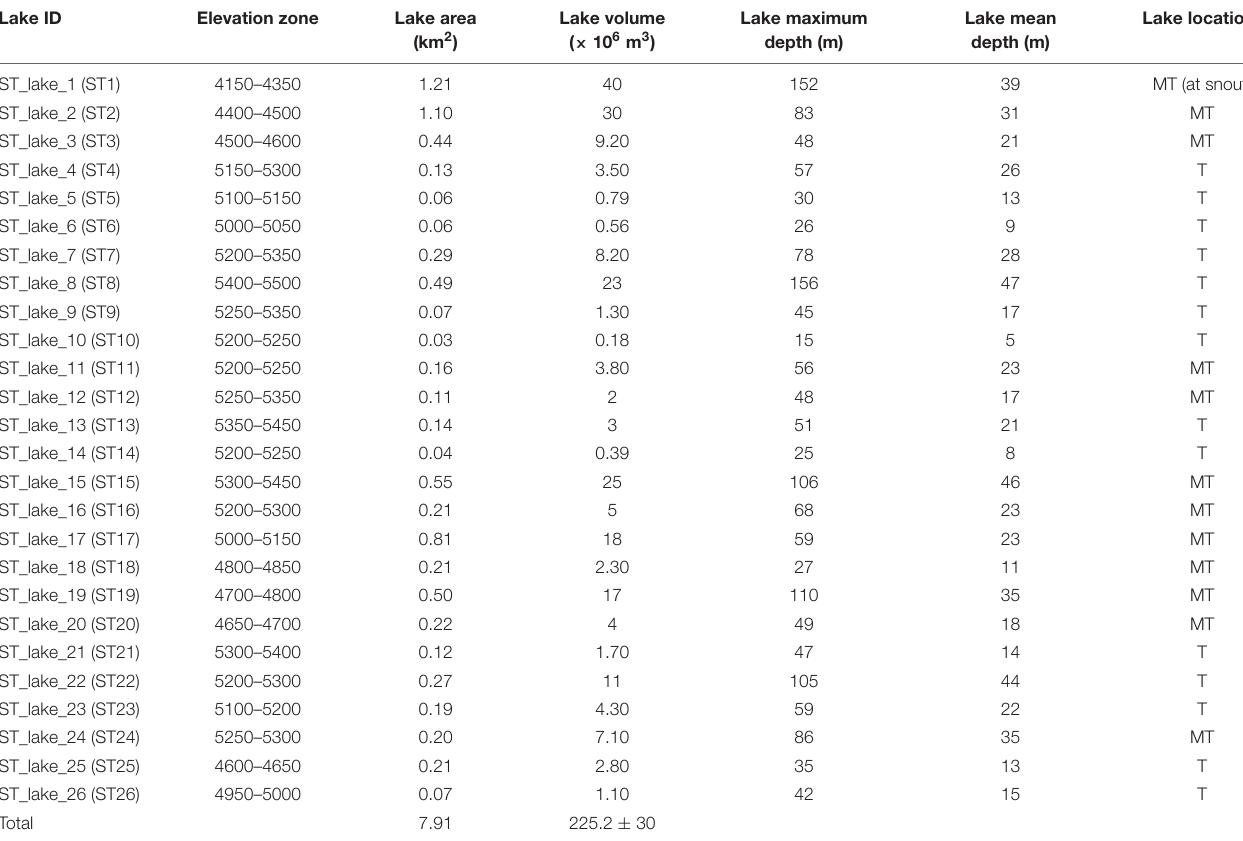
TABLE 3 | Physical attributes of the identified potential sites of future lake formation in the Samudra Tapu Glacier. Lake ID Elevation zone Lake area